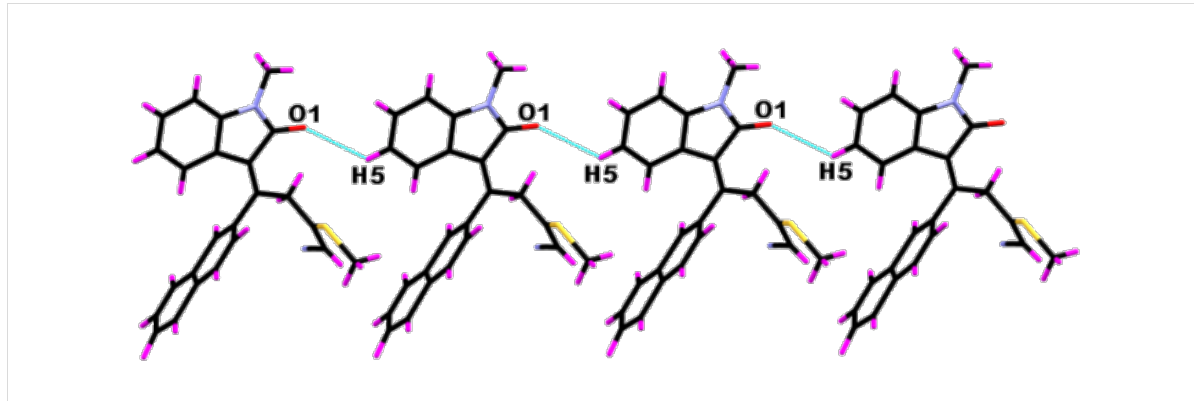
Figure 4: Supramolecular chain of 8yc bound by weak C − H … O intermolecular interactions (symm. op. x ,1 + y , z ).